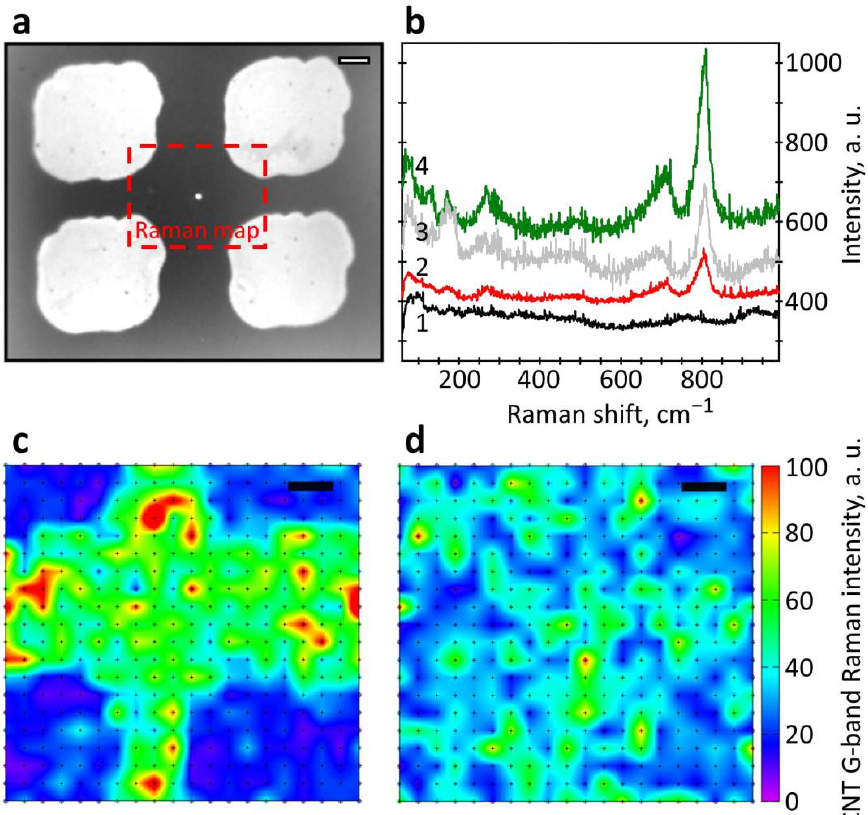
Figure 4. The characterization of the sensor structures under study with Raman spectroscopy: ( a ) optical image of WO 3 /Pt/W areas on glass substrate of SWCNT50-Pt and SWCNT40-WO 3 structures; ( b ) Raman spectra related to thin WO 3 layer, of 7 – 15 nm, on glass area (1), thin WO 3 on Pt/W, SWCNT50-Pt (2), WO 3 continuous film, ca.~25 nm, on glass, SWCNT40-WO 3 (3), WO 3 continuous film on Pt/W, SWCNT40-WO 3 (4); ( c , d ) G-peak Raman maps for SWCNT50-Pt ( c ) and SWCNT40-WO 3 ( d ) structures. The scale bar is 5 μm.